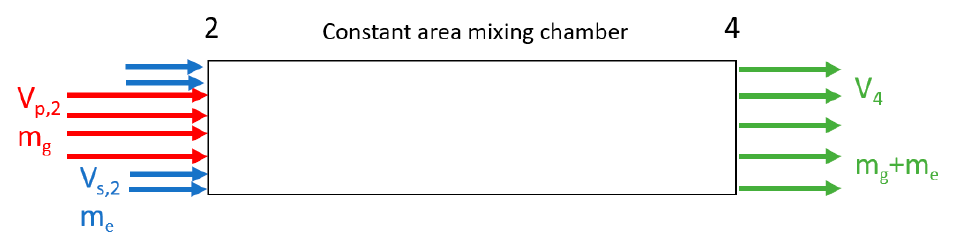
Figure 3. Conservation of momentum in constant area mixing chamber before shock .